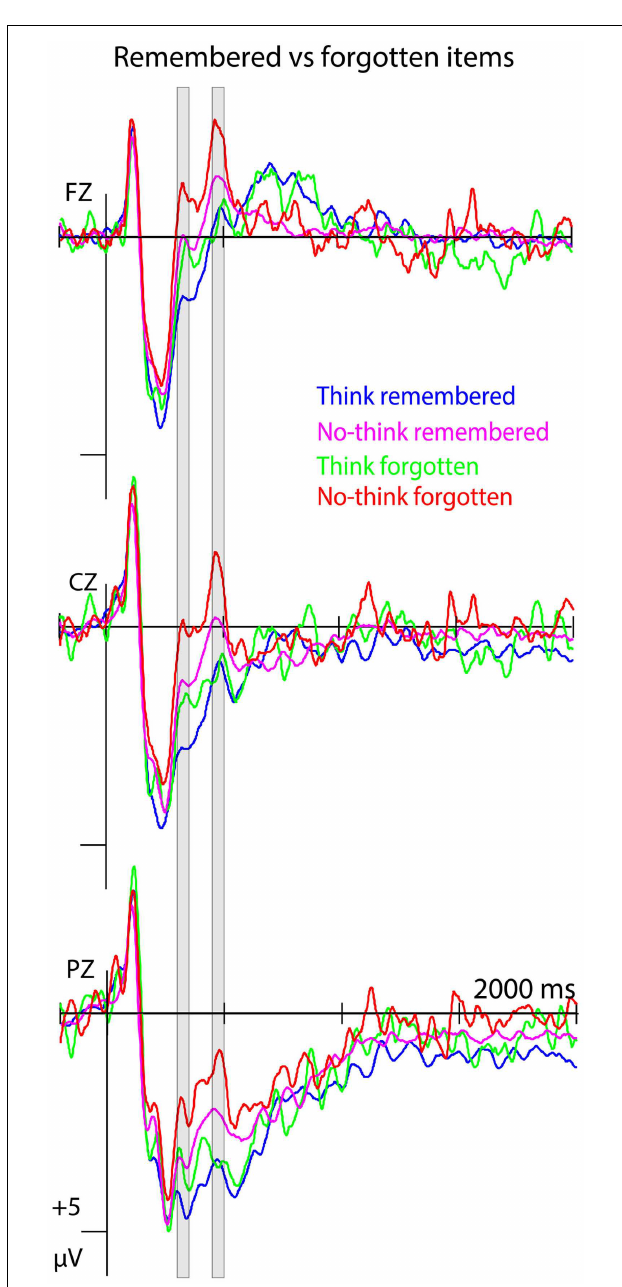
FIGURE 4 | Forgetting effects at the item level. ERPs to forgotten and remembered items from both think and no-think conditions at midline electrode sites ( n = 15). Negative polarity is plotted upwards.